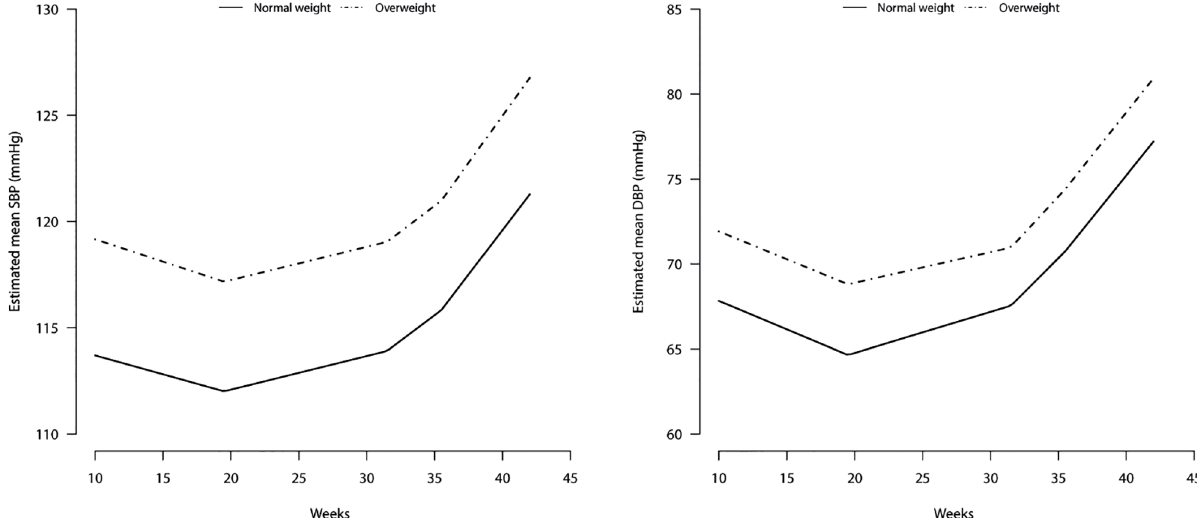
Fig 2. Blood pressurecourse during pregnancy stratified for women with normal weight and overweight. (A) Systolic blood pressure (SBP): 10–16.5weeks: estimated β = -0.2 mmHg/week (95% CI: -0.3;-0.1), 16.5–31.5 weeks: estimated β = 0.2 mmHg/week (95% CI: 0.1;0.2), 31.5–35.5 weeks: estimated β = 0.5 mmHg/week (95% CI: 0.4;0.6), 35.5–42weeks: estimated β = 0.9 mmHg/week (95% CI: 0.7;1.0). (B) Diastolic blood pressure(DBP): 10–19.5weeks: estimated β = -0.3 mmHg/week (95% CI: -0.4;-0.3), 19.5–31.5 weeks: estimated β = 0.2 mmHg/week(95% CI: 0.2;0.3), 31.5–35.5 weeks: estimated β = 0.8 mmHg/week (95% CI: 0.7;0.9), 35.5–42weeks: estimated β = 1.0 mmHg/week(95% CI: